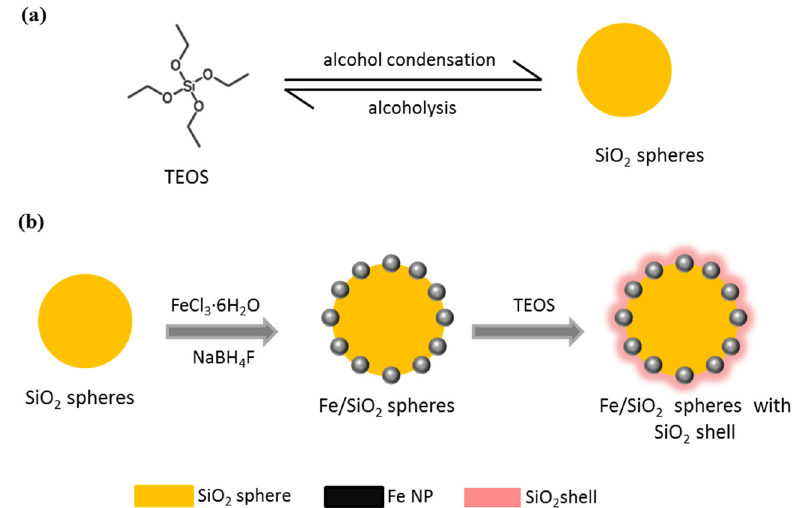
Figure 1. Diagram outlining the synthesis process of Fe/SiO 2 spheres with the SiO 2 shell (abbreviated as SiO 2 @Fe/SiO 2 composite spheres): ( a ) the SiO 2 spheres were prepared by tetraethyl orthosilicate (TEOS) condensation; ( b ) the formation of metallic Fe-containing nanoparticles (Fe NPs) on the SiO 2 spheres by the addition of iron chloride hexahydrate (FeCl 3 ∙ 6H 2 O) in the SiO 2 ‐ sphere suspension as the iron source, reduced with sodium borohydride (NaBH 4 ) and followed by TEOS addition again for coating SiO 2 shells to prevent the oxidation of metallic Fe NPs on the shells.